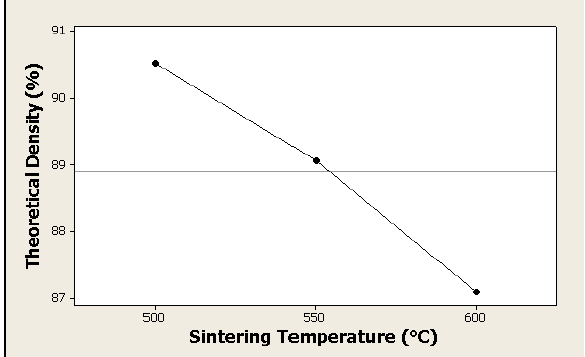
Figure 5. Effects of sintering temperature on the density of AZ31 magnesium